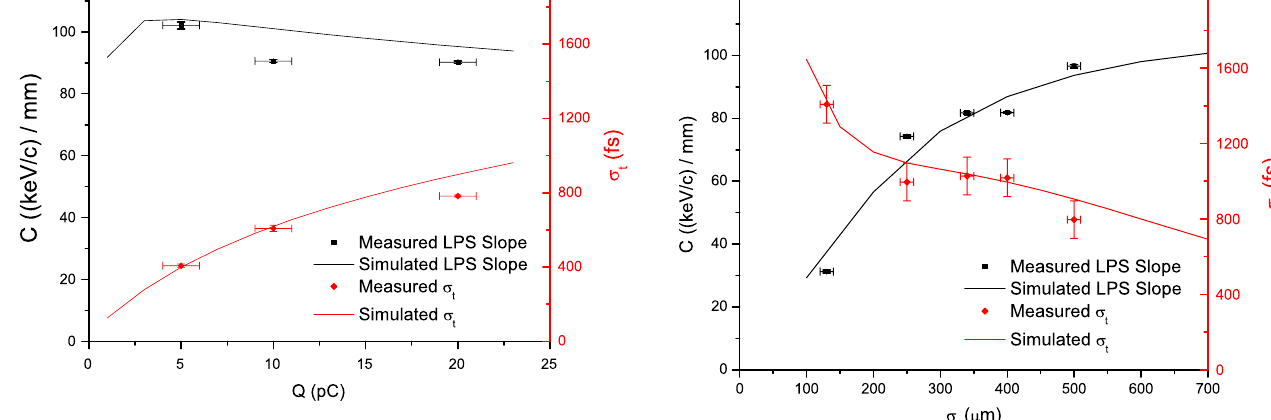
FIG. 7. (Color) A scan of the chirp ( C ) (left axis, black) and (cid:8) t (right axis, red) versus (cid:8) l . The measured values (points) are ¼ 22 compared to GPT simulations. The scan was performed with 0 ¼ 22 degrees 20 pC of charge and an rf gun phase of (cid:11) 0